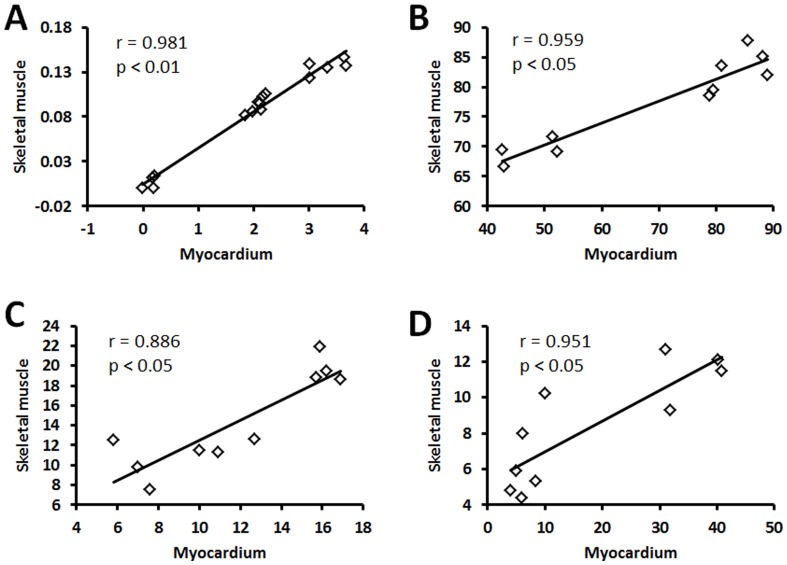
The correlation curves of mtDNA deletion rate between myocardium and skeletal muscle, and mitochondrial membrane phospholipids loss rate between myocardium and skeletal muscle in VMC mice.The correlation of mitochondrial membrane phospholipids normal localization between myocardium and skeletal muscle in VMC mice was described in part b, R = 0.959, p<0.001; the correlation of partial loss of mitochondrial membrane phospholipids was described in part c, R = 0.886, p = 0.03; the correlation of most or complete loss was described in part d, R = 0.951, p = 0.001.